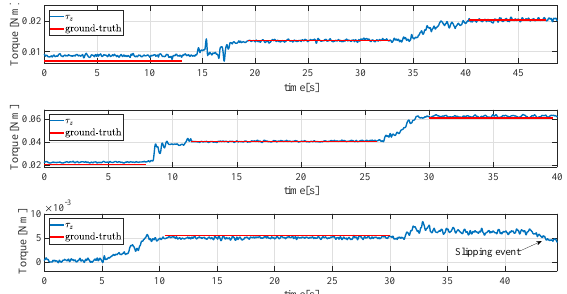
Figure 24. Fifth experiment: Validation of the calibration of the torsional moment component, with f n = 5N ( top ), f n = 15N ( middle ), f n = 2.5N ( bottom ).